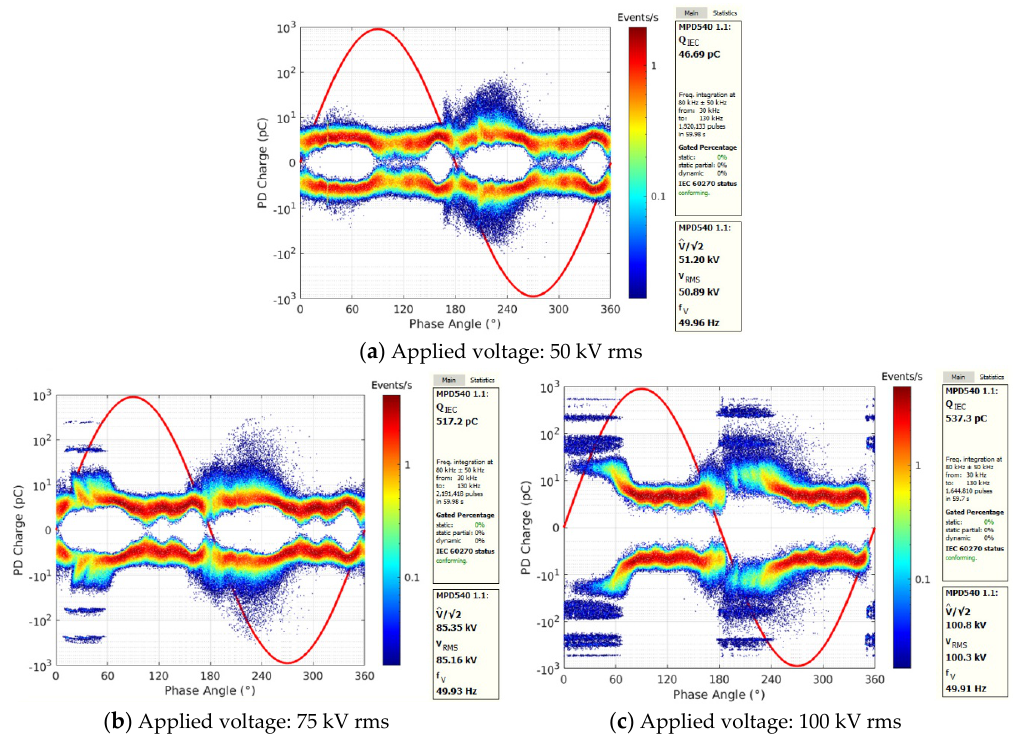
Figure 8. PD measurement of the gas insulated line demonstrator filled with 3 bar CO 2 —particle-contaminated system—measured directly with a HV coupling capacitor.